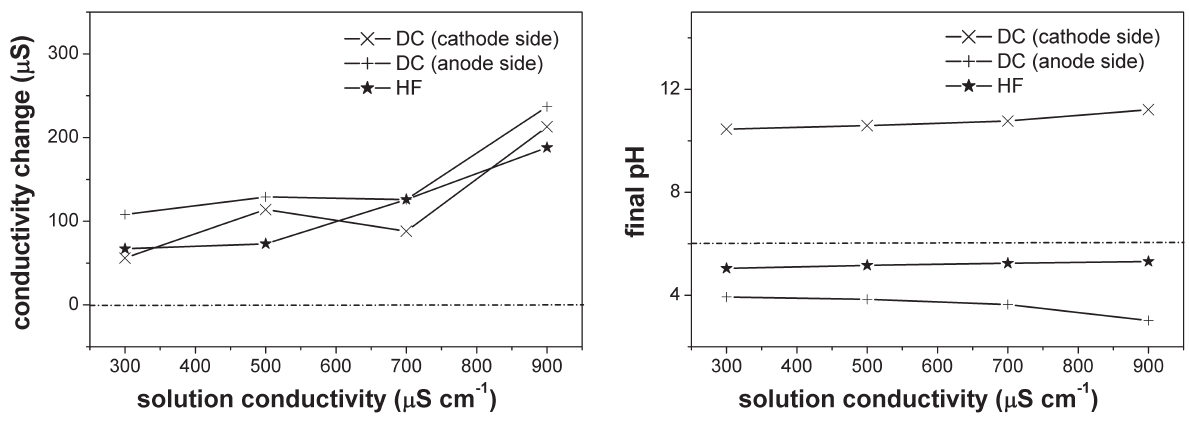
Figure 7: Changes of solution conductivity (left) and final pH values (right) after 40 minute discharge operation (45 W) plotted as a function of initial solution conductivity; NaCl solution, dielectric barrier thickness of 0.6 mm, pin-hole diameter of 0.6 mm; dash lines indicate initial values of plotted parameters (initial pH of 6.0).